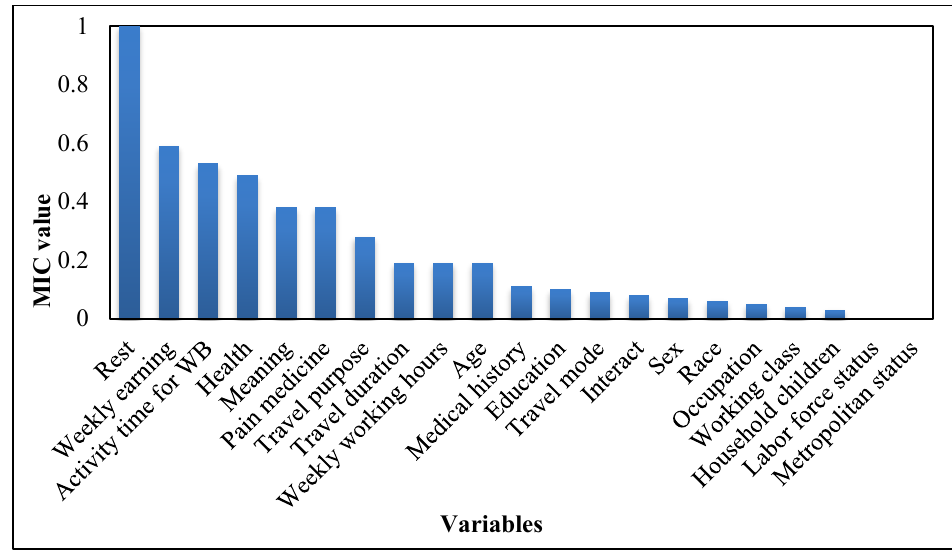
Figure 1. Rank of feature’s maximal information coefficient .